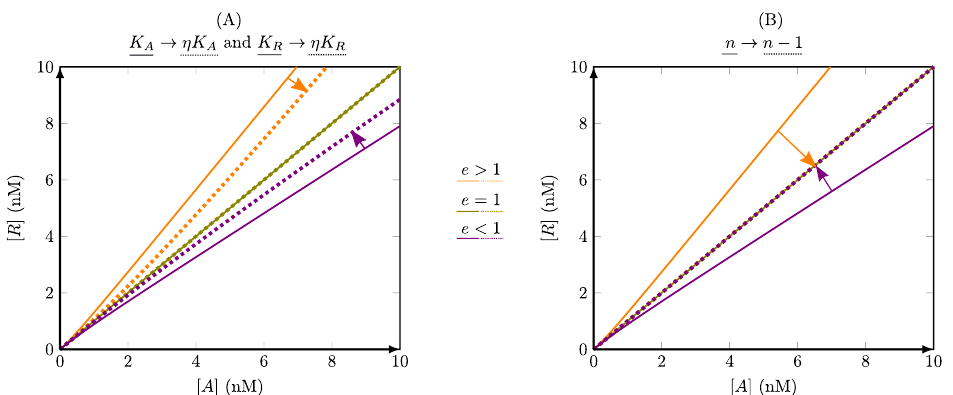
Figure 3. Activation-repression threshold variations under TFs signalling interferences (6) and (7). Thresholds determined by a stimulated BEWARE operator exhibiting different elasticities depending on the values of the model parameters. Orange, green and purple continuous lines are used to repre- sent thresholds with elasticity greater than, equal to or less than one, respectively. In ( A ) perturbation, (6) has been applied with η = 10. In ( B ) perturbation, (7) is where the number of enhancers changes from n = 2 to n = 1. The thresholds after perturbations are depicted in both cases as dotted lines. Orange and purple arrows show the threshold variations in the elastic and inelastic cases, since in the unit elastic case (green threshold) there is no change, in accordance with Equation (9). Parameter values can be found in Table S4, Supplementary Materials Section S8 and the estimation of the elasticities for these values are in Table 1. Table 1. Analytical estimations of elasticity for thresholds deduced from the BEWARE operators in the global activator/repressor framework. The values t 1 , h 1 , t 2 , h 2 appearing in the case of the stimulated operator with two enhancers are defined in terms of the rest of the model parameters (see Section S6.2 in Supplementary Materials, for explicit definitions). Act Coop. Null/Total Coop. Rep